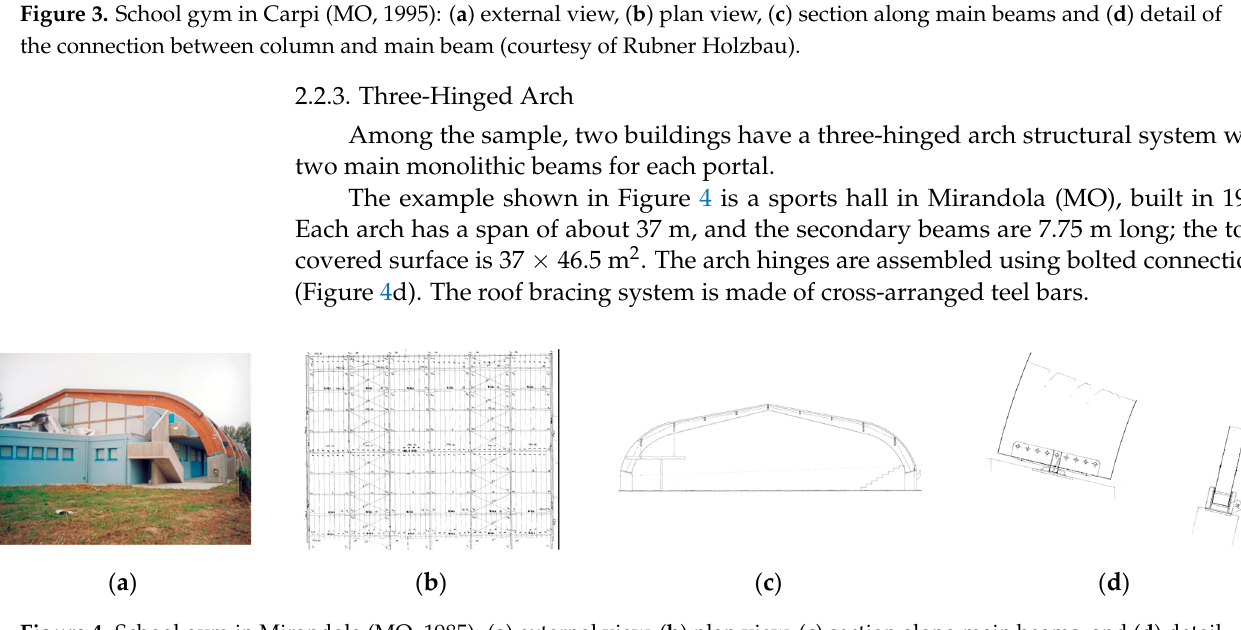
Figure 5. Pool in Acquasanta Terme (AP, 2006): ( a ) external view, ( b ) plan view, ( c ) section along main beams, and ( d ) detail of the connection between column and main beam (courtesy of Rubner Holzbau). 3. The CARTIS Large Spans Form 3.1. Overview of the CARTIS Large Spans Form The first level CARTIS form was designed to provide information on the different types of buildings commonly found in municipal (or province) or sub-municipal areas (districts), characterized by a homogeneous structural typology, construction age, types, and similar structural techniques. The goal is to define an organized database to collect the typological and structural characteristics of the buildings and, therefore, to quantify the exposure on a territorial scale. The CARTIS form is based on the extensive experience acquired in the development and application of the AeDES form (Section 1), although the contents are different. It is divided into the following four sections: Section 0 : for the identification of the municipality (or province) and districts; Section 1 : for the identification of each prevalent constructive type within the dis- tricts; Section 2 : for the identification of the general characteristics of the constructive types analyzed; Section 3 : for the characterization of the structural elements of the constructive type analyzed. Below, “CARTIS Large Spans form [19]: 1st level form for the typological structural characterization of large span buildings” (Annex A and B) is described in more detail. In particular, it consists of two main parts. The first part, nine pages and three sections, is